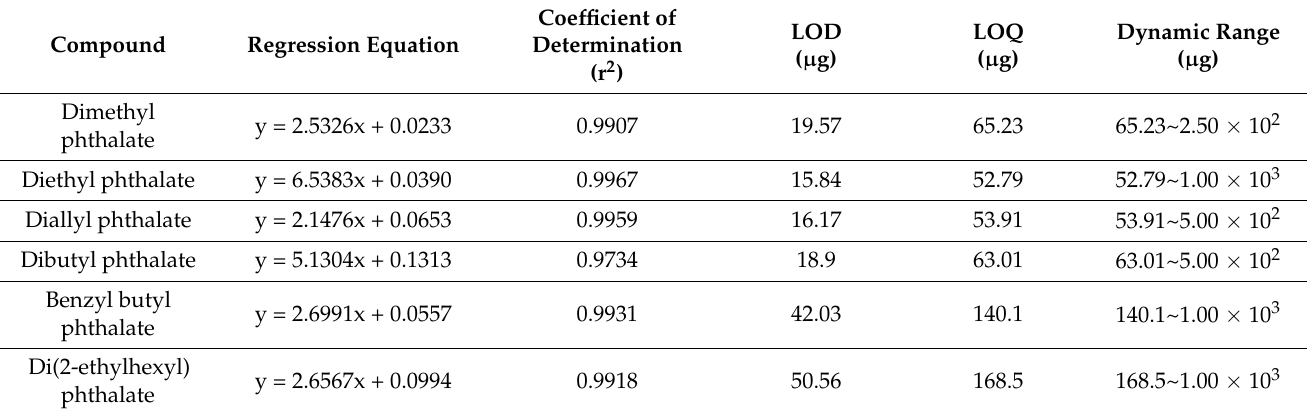
Table 1. Validation data of HS–INME using MWCNT–IL/PANI and GC/MS ( n = 3).